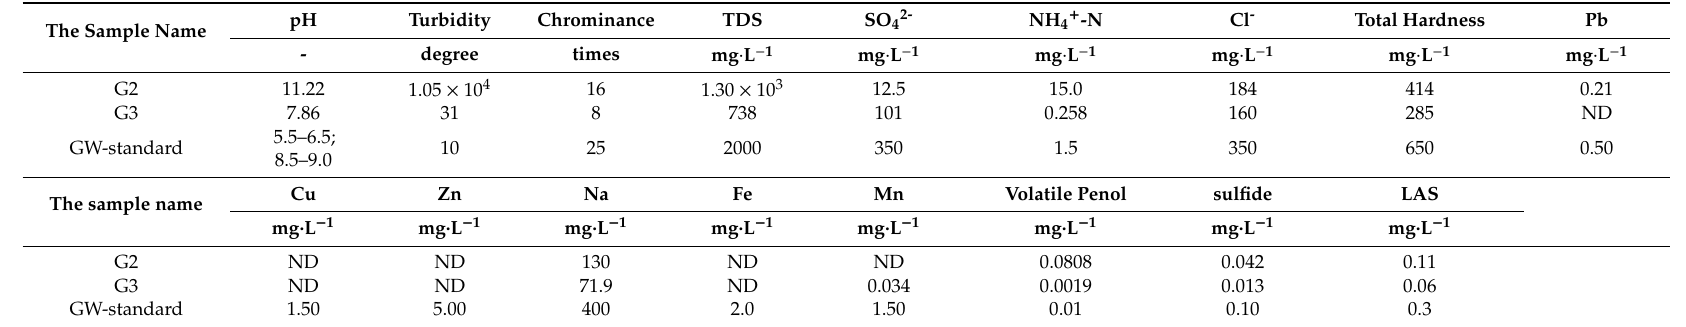
Table 5. Groundwater quality test